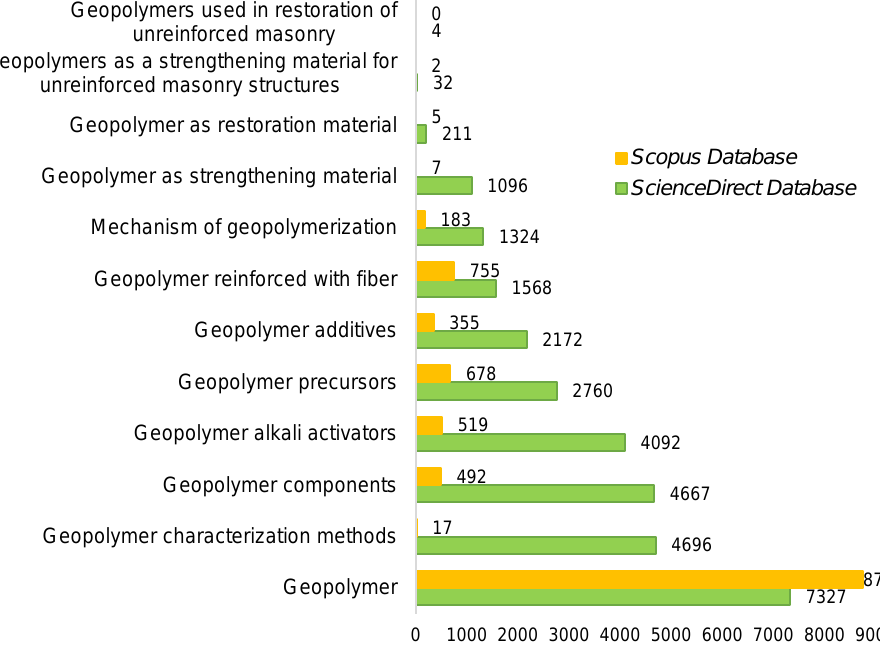
Figure 15. Number of research articles about geopolymer found in the Scopus and ScienceDirect databases.